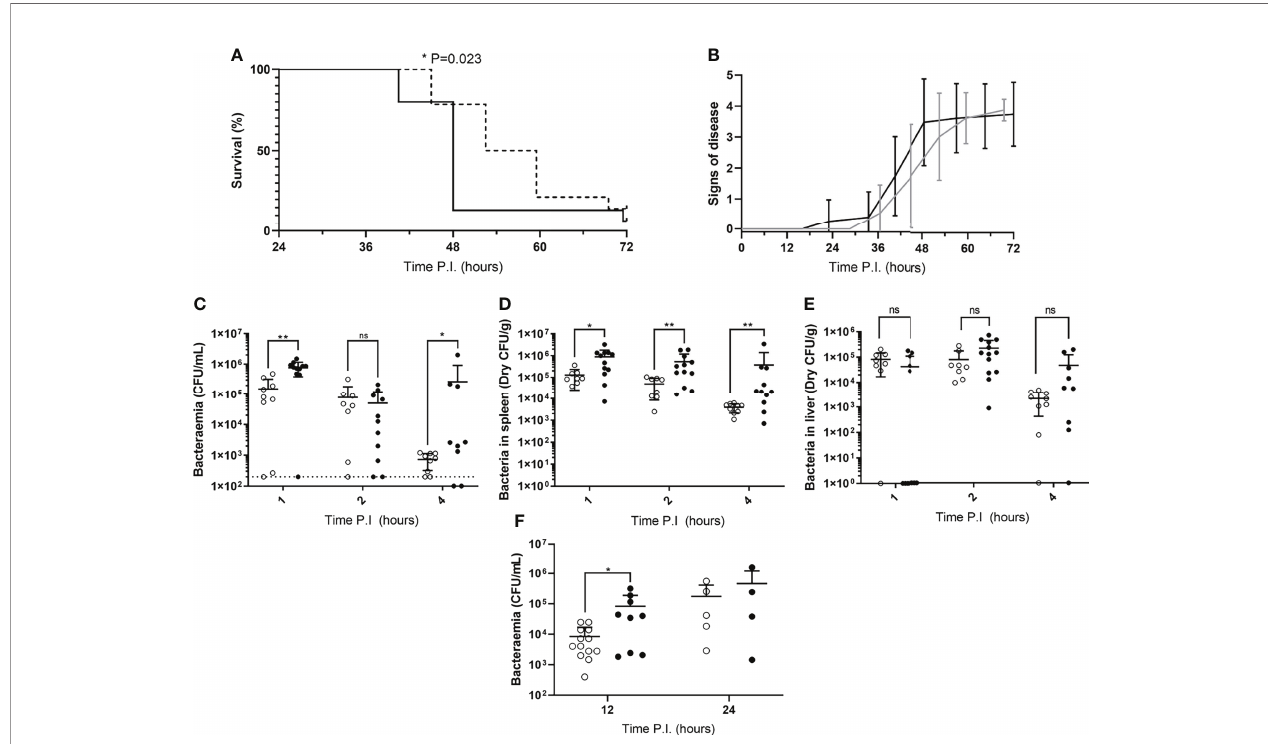
FIGURE 1 | Disease severity and bacterial burdens of blood and organs from mice infected during their rest or active phases. (A) CD1 mice (n=30) were IV infected during their rest (dotted line) or active (solid line) phase and sacri fi ced once visible clinical signs consistent with moderate septicaemia were reached. Survival curves were compared by Gehan-Breslow-Wilcoxon survival curve test (*; P=0.0232). (B) Mice in (A) were regularly scored for signs of disease equating to 0: normal, 1: hunched, 2: piloerect, 3: hunched + piloerect, 4: lethargic + very hunched or very piloerect. Rest and active phase-infected mice are represented by grey and black lines respectively. Blood CFU/mL (C) , spleen CFU/g (D) , and liver CFU/g (E) bacterial CFU counts were enumerated from mice (n=30) at 1, 2 and 4h PI. Rest and active phase-infected mice are represented by open and fi lled points respectively. The limit of detection for blood CFU counts is indicated by the horizontal dotted line. Statistical signi fi cance was determined at each time point between both groups of mice by Mann-Whitney test (ns, P>0.05; *P ≤ 0.05; **P<0.01). (F) Blood bacteria CFU counts from mice (n=31) were determined at 12 and 24h PI. Rest and active phase-infected mice are represented by open and fi lled points respectively. Statistical signi fi cance was determined at each time point between both groups of mice by Mann-Whitney test